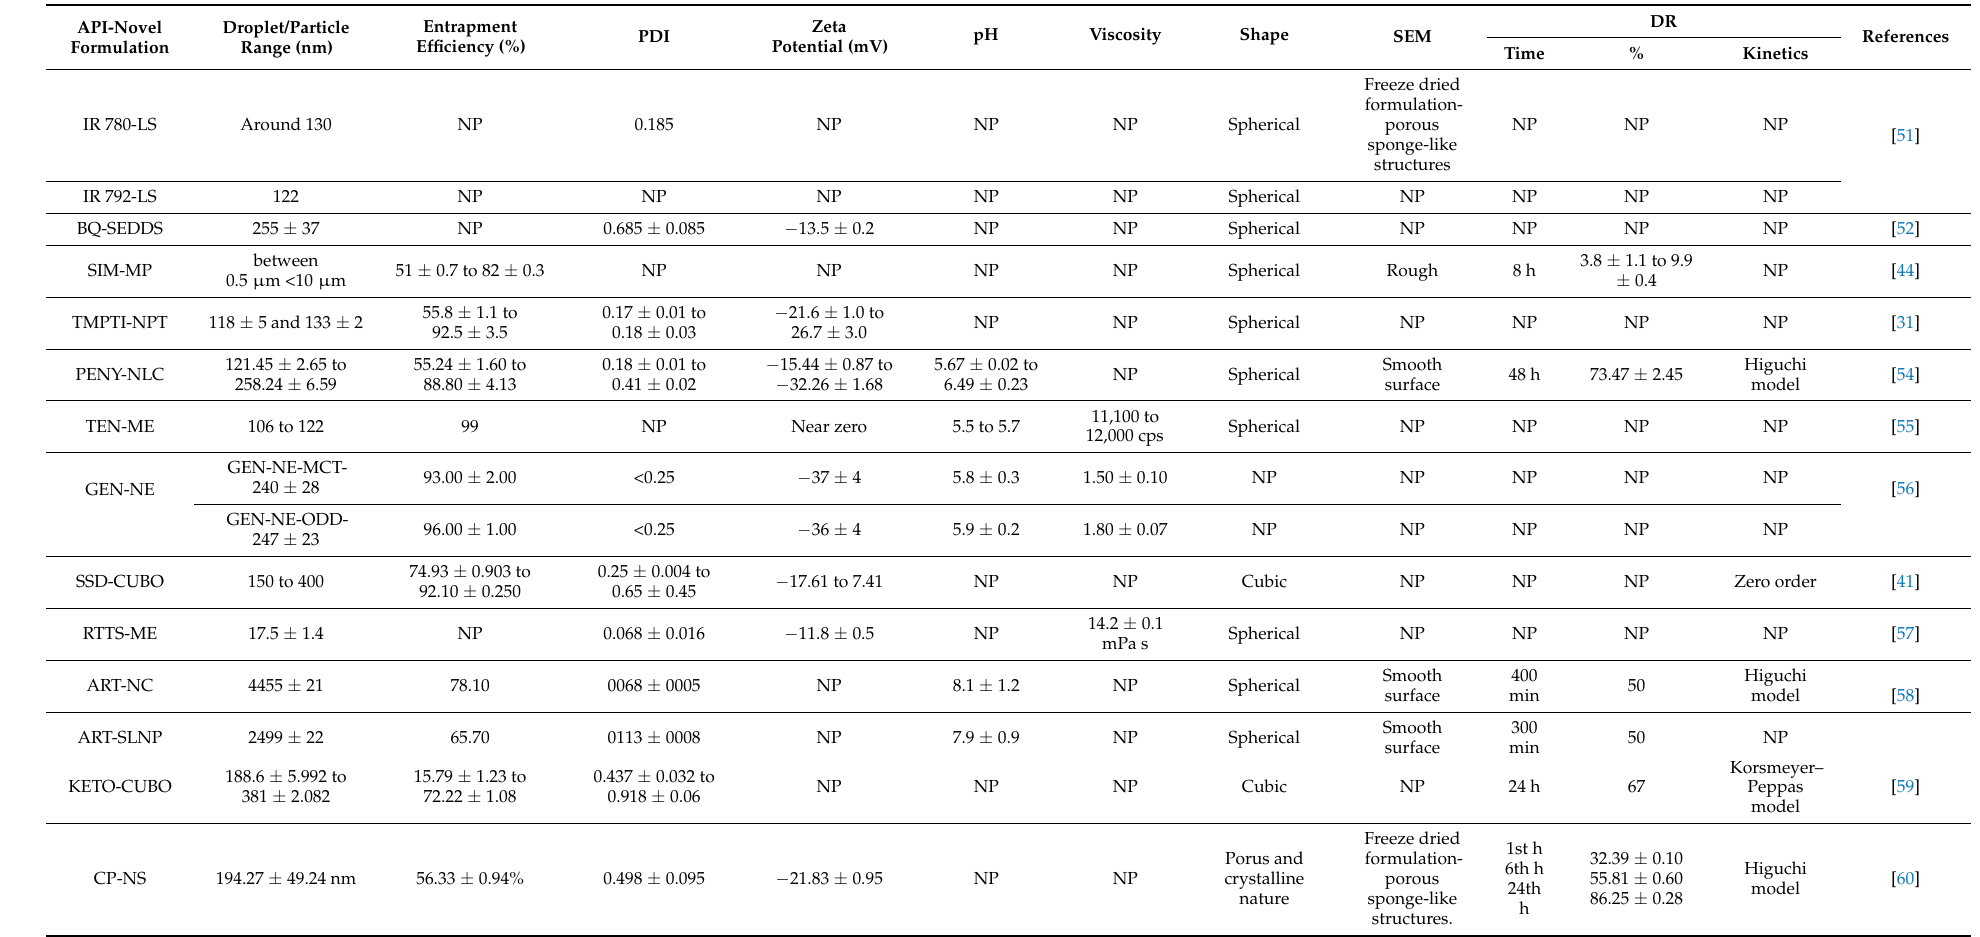
Table 6. Different novel formulation evaluation studies before incorporating into hydrogel.